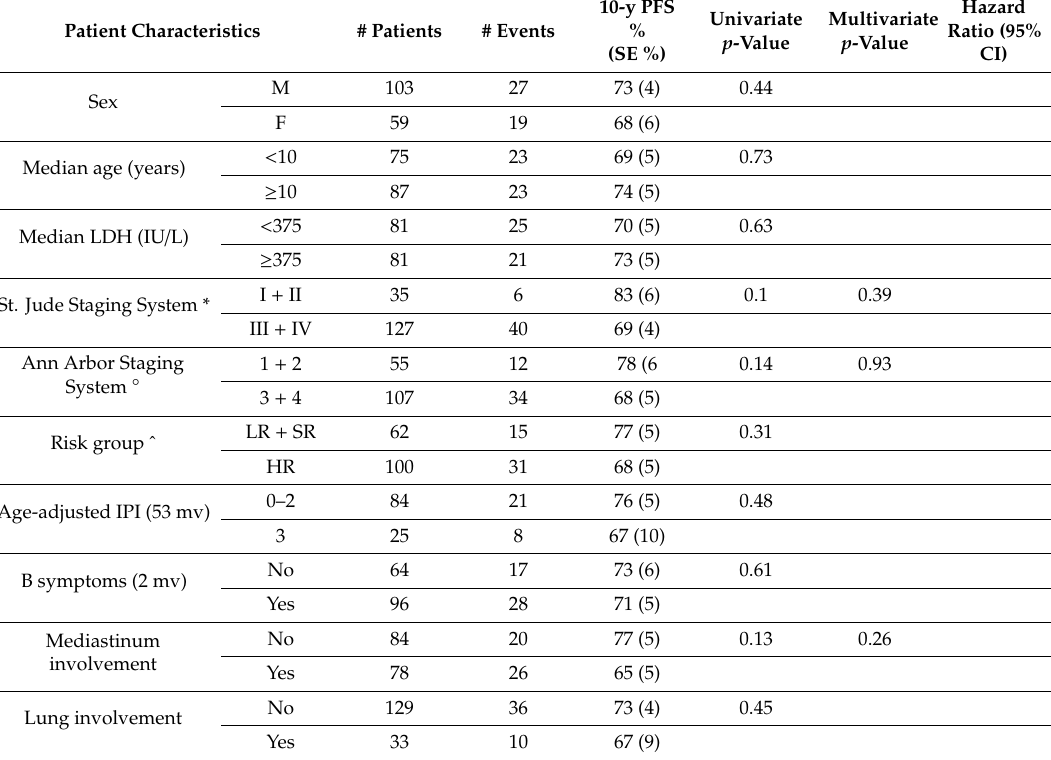
Table 2. Patient and disease characteristics of the 162 patients with minimal disseminated disease data